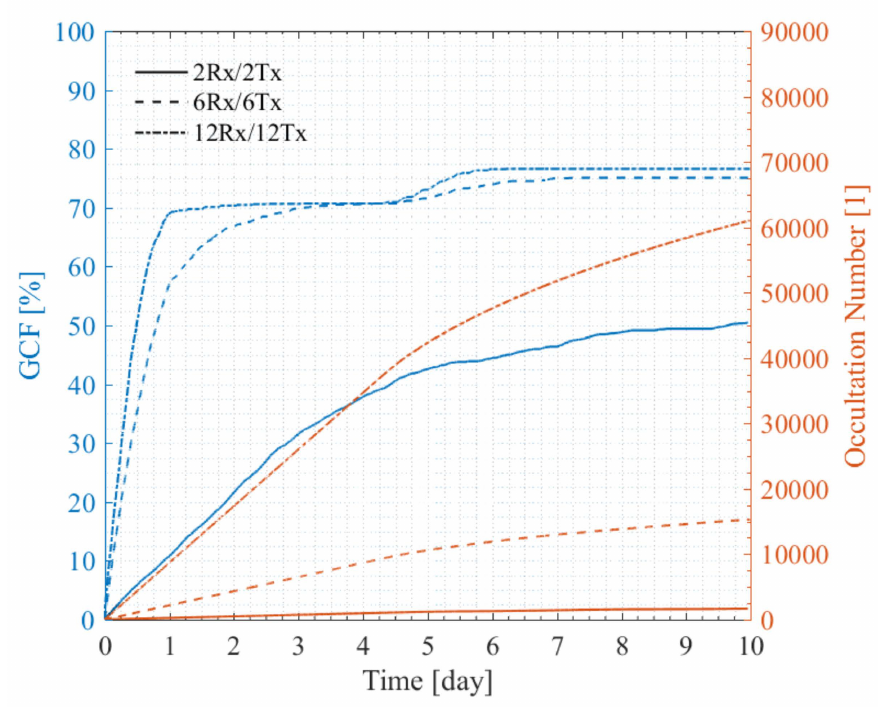
Figure 14. Accumulated time dependence of the global coverage fraction (GCF) (blue lines) and the occultation event number (orange lines) for the 2Rx/2Tx, 6Rx/6Tx, and 12Rx/12Tx constellations with the Rxi140 and Txi40 inclination orbital